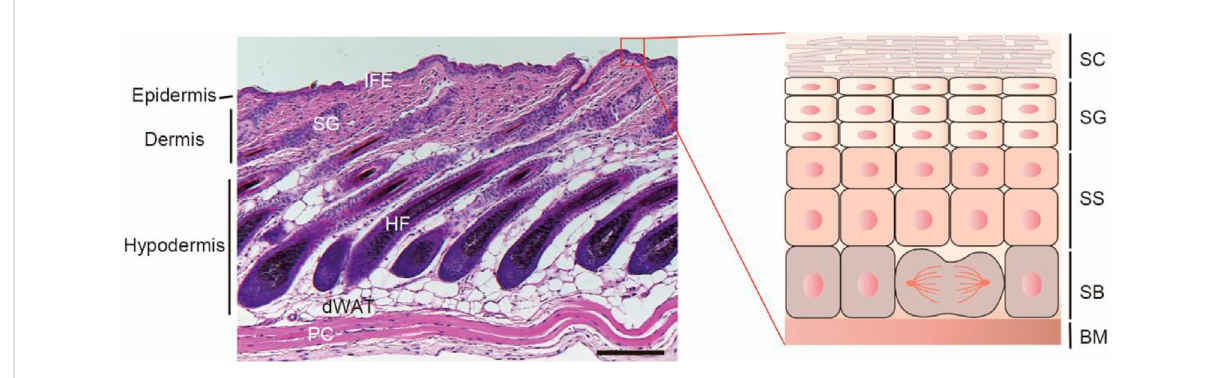
FIGURE1 Theskinarchitecture.Left,hematoxylinandeosin(H&E)-stainedP32mouseback-skinsection.Theskiniscomposedofthreelayers:epidermis, dermis and hypodermis. The epidermis is the out layer and compartmentalized into interfollicular epidermis and its appendages, such as hair follicle and sebaceous gland. IFE, interfollicular epidermis; SG, sebaceous gland; HF, hair follicle; dWAT, dermal white adipose tissue; PC, panniculus carnosus muscle. Scale bar, 100 µm. Right, scheme of interfollicular epidermal structure. According to the keratinocyte differentiation stage, cell morphology and marker expression, IFE can be distinguished into four layers: stratum basale (SB), stratum spinosum (SS), stratum granulosum (SG), and the stratum corneum (SC). SB is attached to the basement membrane (BM), which separates the epidermis and